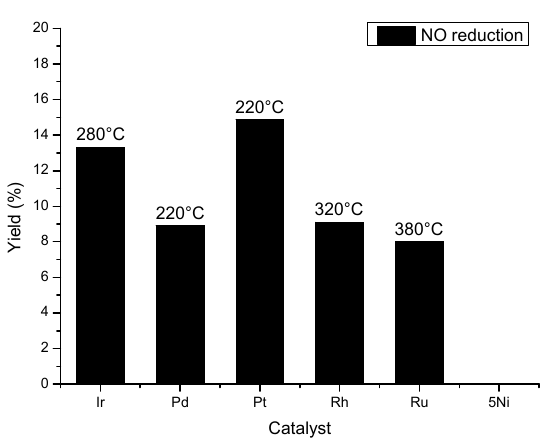
Figure 7. NO reduction at total oxidation of CO. Feedstream composition: 0.02% NO, 0.5% CO, 10% O 2 and 20% CO 2 , and balance He. Space velocity: 2.24 10 4 h − 1.